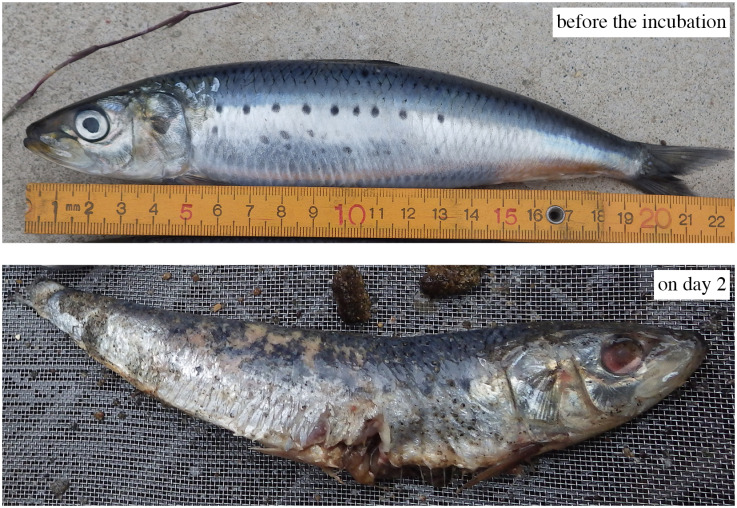
Photographs of Sardinops melanostictus before the experiment (upper panel) and at the two days after the incubation (lower panel).